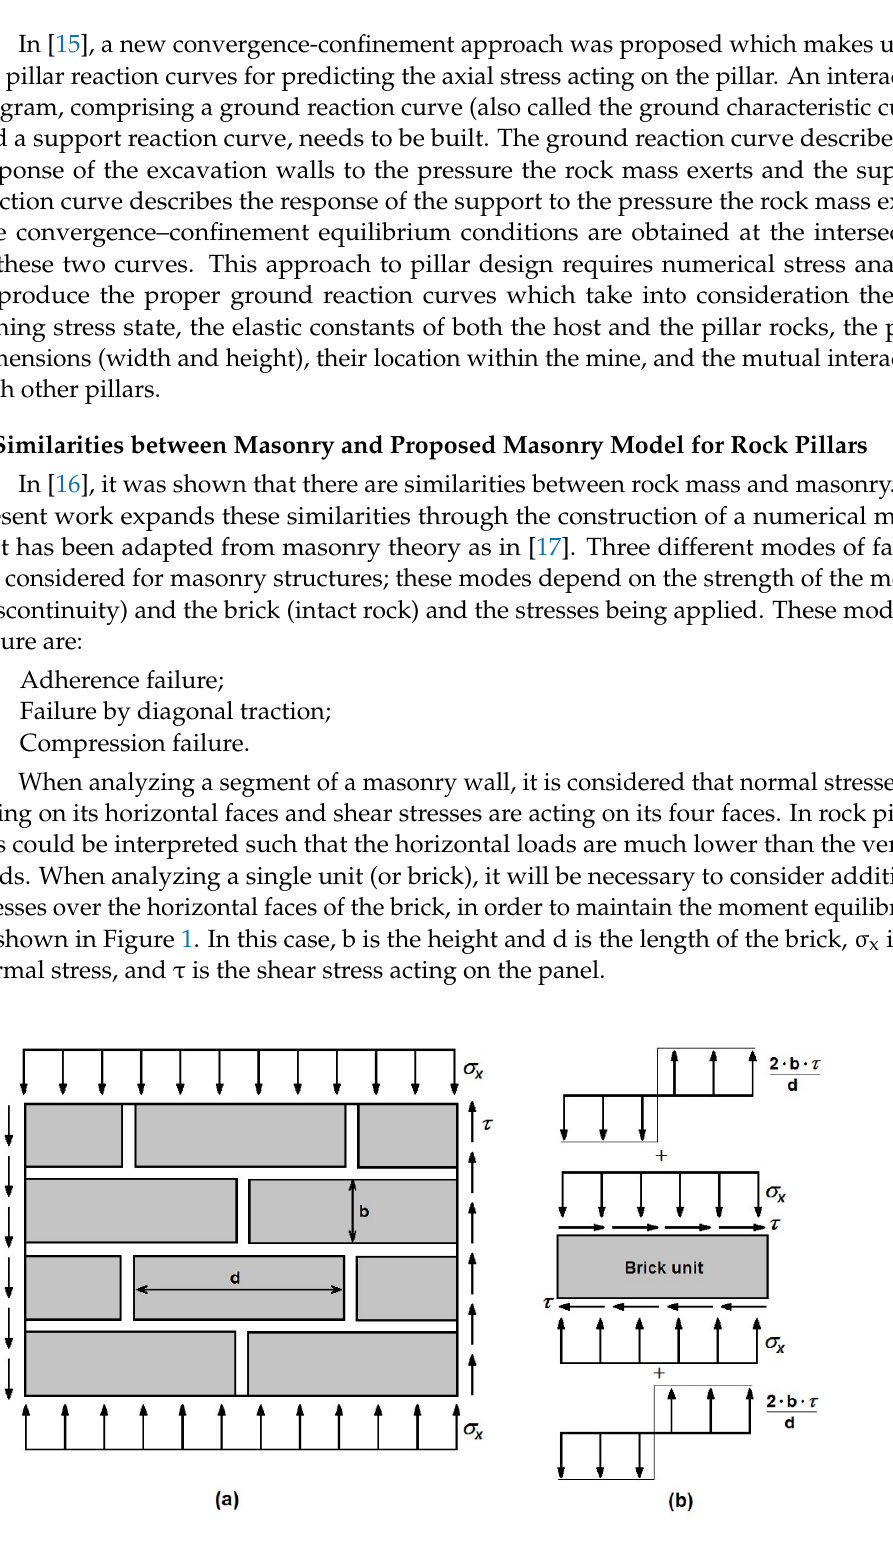
Figure 1. Masonry from [17]. ( a ) Stress state acting on a masonry panel, ( b ) stress state acting on a brick.